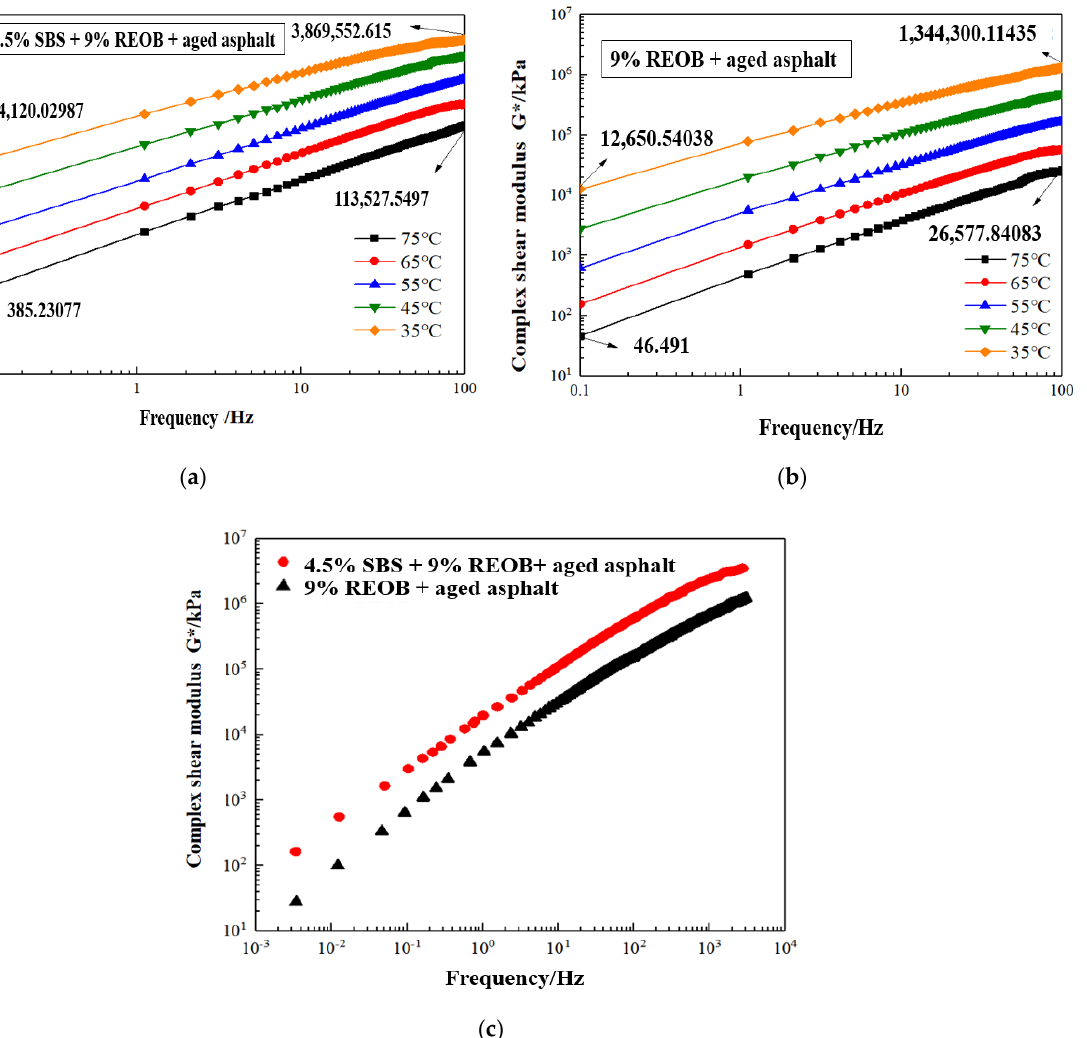
Figure 5. ( a ) lg G* − lg f double logarithmic curve of complex modulus and frequency of 4.5% SBS + 9% REOB + aged asphalt modified rejuvenated asphalt; ( b ) lg G* − lg f double logarithmic curve of complex modulus and frequency of 9% REOB + aged asphalt rejuvenated asphalt; ( c ) main curve. We took the logarithm of the G* - f test results at different temperatures and performed linear fitting. Taking the complex shear modulus as lg G* = 5 Pa, the lg f corresponding to